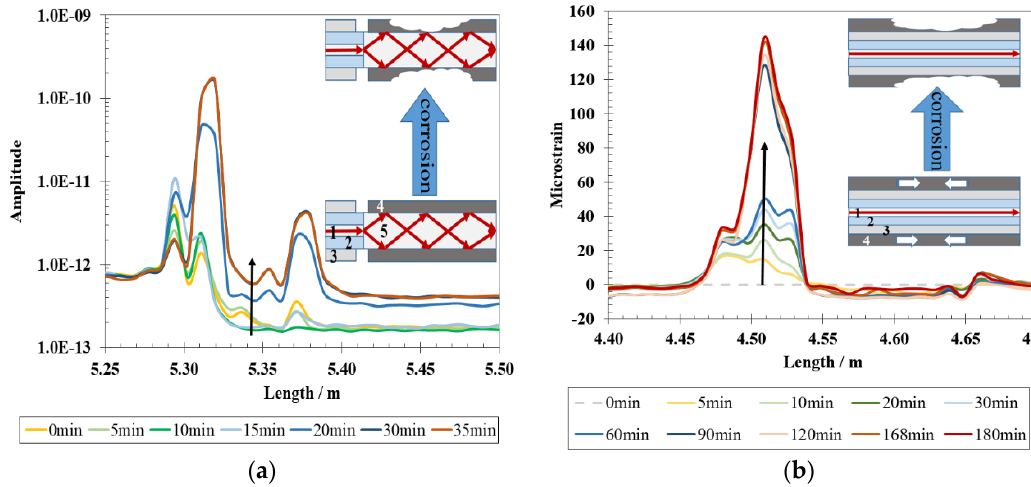
Figure 16. Metallic thin film coated optical fiber sensors (OFS) for distributed corrosion sensing interrogated using Optical Frequency-Domain Reflectometry (OFDR): ( a ) Rayleigh backscattered light increases as corrosion of Fe proceeds due to light absorption of metallic film; ( b ) Microstrain on the fiber increases with mass loss of coated Ni film due to release of compressive internal stress induced by Ni deposition [102]. Note: 1—single-mode fiber core; 2—cladding; 3—polymer jacket; 4—coated metallic film; 5—multi-mode fiber core.